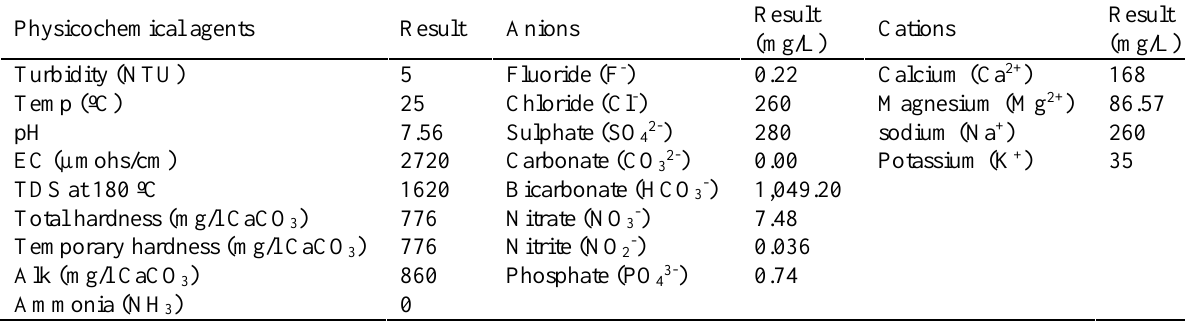
Table 2. The results of the physicochemical parameters of the collected water sample Physicochemical agents Result